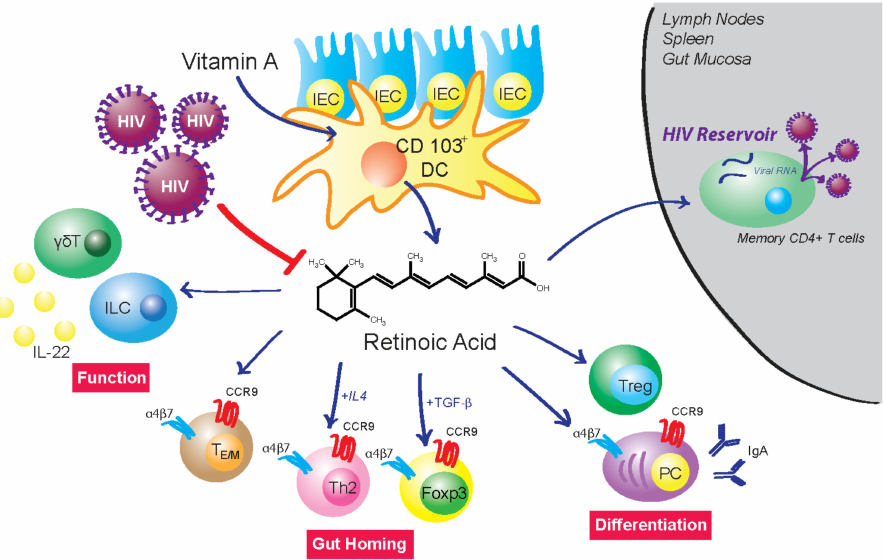
Figure 8. HIV infection disrupts RA-mediated control of intestinal homeostasis . Mucosal CD103 + dendritic cells (DC) express Raldh2 and are a major source of RA production in the gut. They